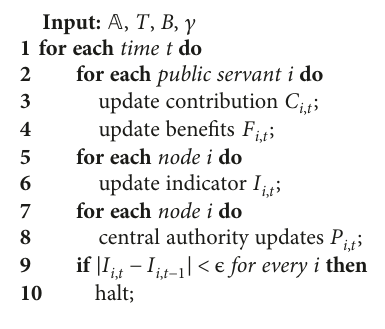
Algorithm 1: Computation